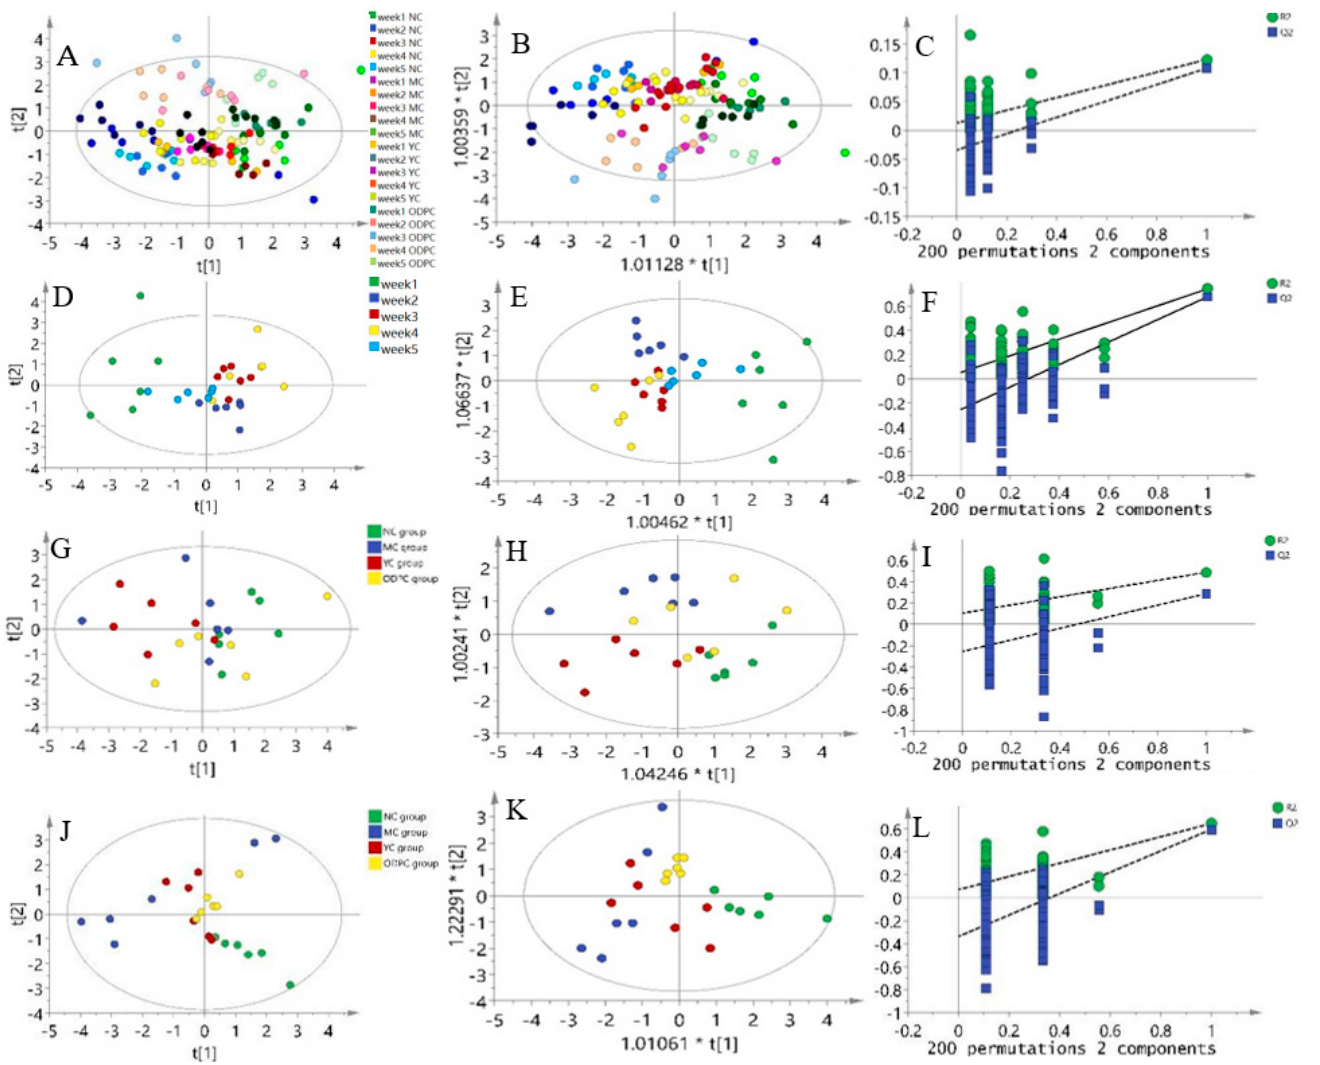
Figure 8. Results of the multivariate statistical analysis of the ODP time dependence study: ( A ) PCA score chart of peripheral blood; ( B ) OPLS-DA score plot of peripheral blood; ( C ) OPLS-DA replacement test diagram of peripheral blood; ( D ) PCA score chart of oral ODP for 35 days; ( E ) OPLS-DA score chart of oral ODP for 35 days; ( F ) OPLS-DA replacement test chart of oral ODP for 35 days; ( G ) PCA score chart of oral ODP for 7 days; ( H ) OPLS-DA score chart of oral ODP for 7 days; ( I ) OPLS-DA replacement test chart of oral ODP for 7 days; ( J ) PCA score chart of oral ODP for 28 days; ( K ) OPLS-DA score chart of oral ODP for 28 days; ( L ) OPLS-DA replacement test chart of oral ODP for 28 days. NC: normal control group. MC: CdCl 2 -treated group. YC: positive-treated group. ODPC: ODP-treated group.